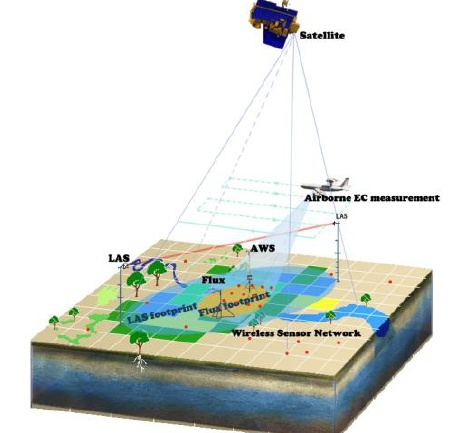
Figure. 3 The typical multi-scale observation characteristic